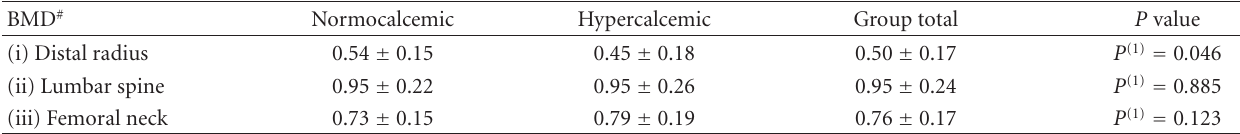
Table 3: Bone mineral density in normocalcemic and hypercalcemic